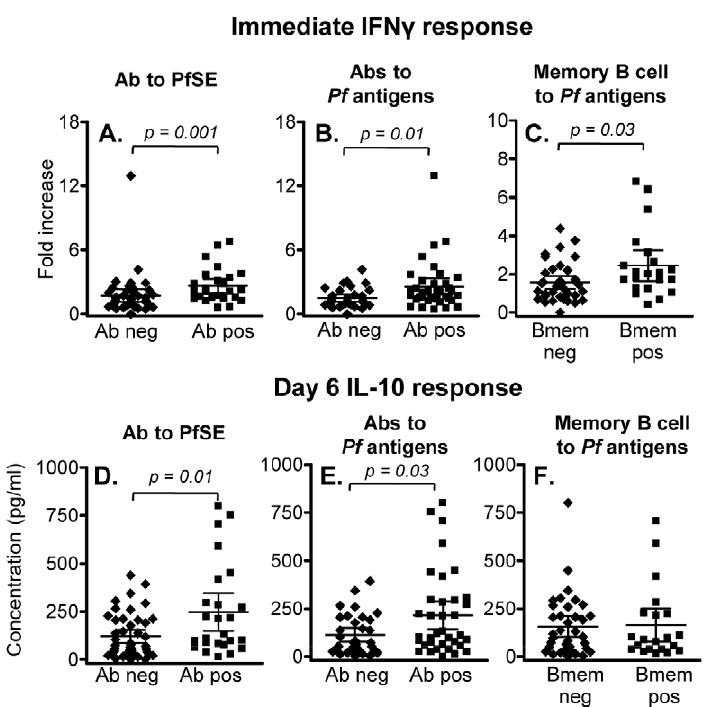
Figure 4. Association between memory T cell responses and humoral immunity to malaria. (A-C) Immediate IFN- c responses in rural individuals with (Ab pos) or without (Ab neg) antibodies to (A) PfSE or (B) recombinant malaria antigens, or (C) individuals with or without detectable memory B cells specific for P. falciparum antigens. The median percentages of immediate IFN- c producing CD45RO + CD4 + T cells in unstimulated control cultures were 0.029, 0.031 and 0.027 in naı¨ve, Rural 1 and Rural 2 subjects, respectively. (D – F) 6 day IL-10 responses in rural individuals with or without antibodies to (D) PfSE or (E) recombinant malaria antigens, or (F) individuals with or without detectable memory B cells specific for P. falciparum antigens. [Horizontal line = median; box =25 th and 75 th percentiles; whiskers = minimum and maximum values]. Mann-Whitney U test was used to analyse differences between groups.